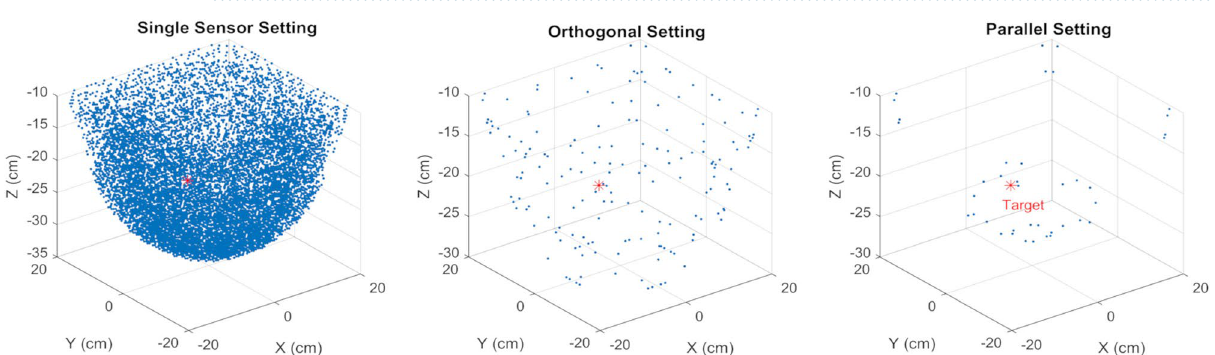
Figure 1. Configuration Settings. Schematic representation of configuration settings employed in the experiments.